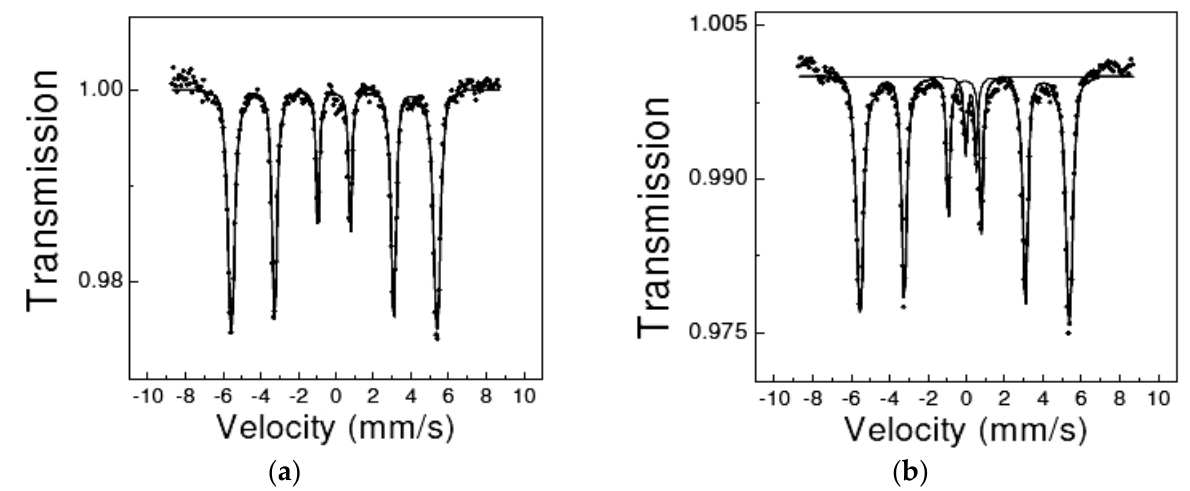
Figure 25. Room temperature Mössbauer spectra of iron meteorite Soledade IAB-MG: interior ( a ) and surface ( b ). Indicated spectral components are the results of the fits. Adapted from [71].